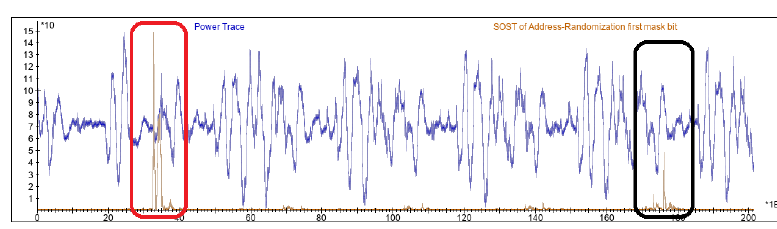
Figure 5: Power trace and the corresponding SOST for address-randomization